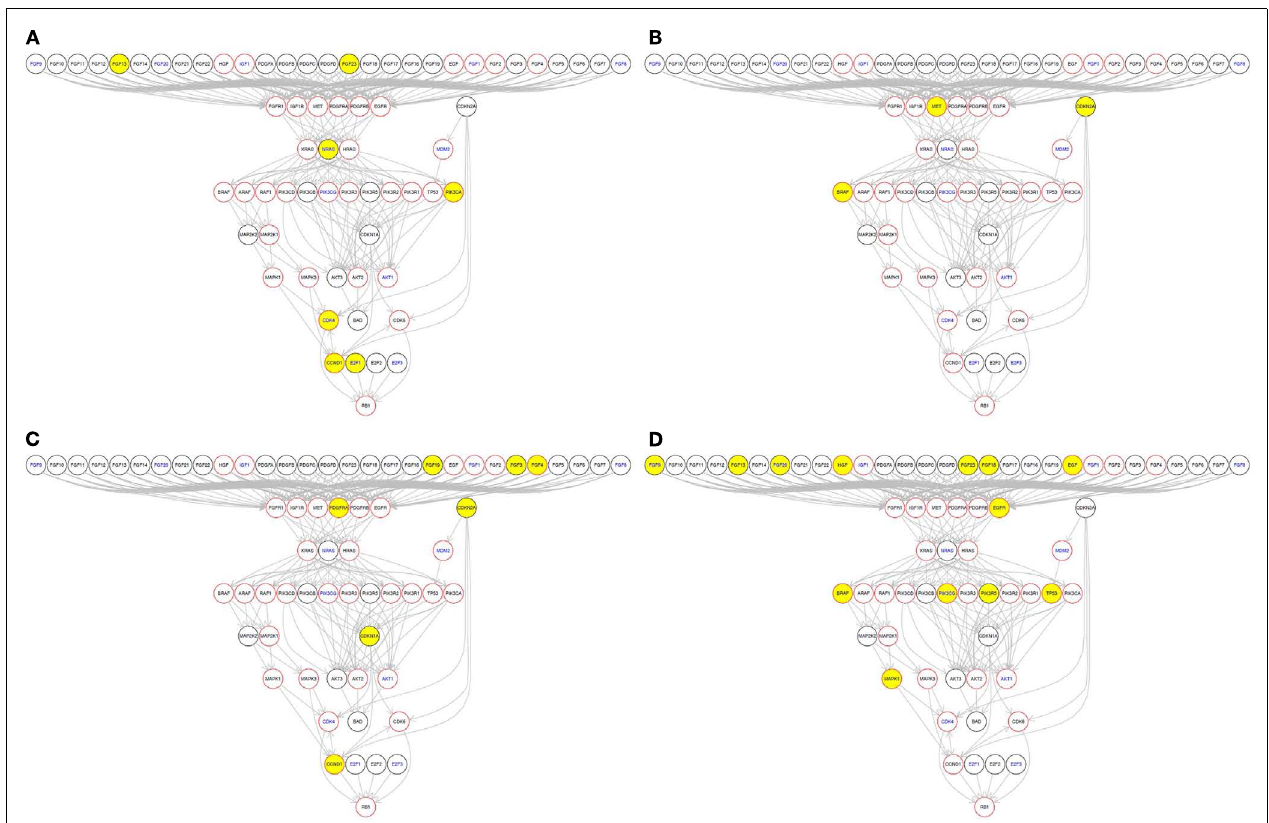
in the data of Bogunovic et al. (50). Four individual tumors with different mutation profiles are shown as examples: (A) ME049 from Berger et al. (6); (B) 01T fromWei et al. (60); (C) melanoma reported byTurajlic et al. (59); (D) YUKLAB from Krauthammer et al. (5).This graph was generated using the pathwayGraph function and KEGG information contained within the R graphite